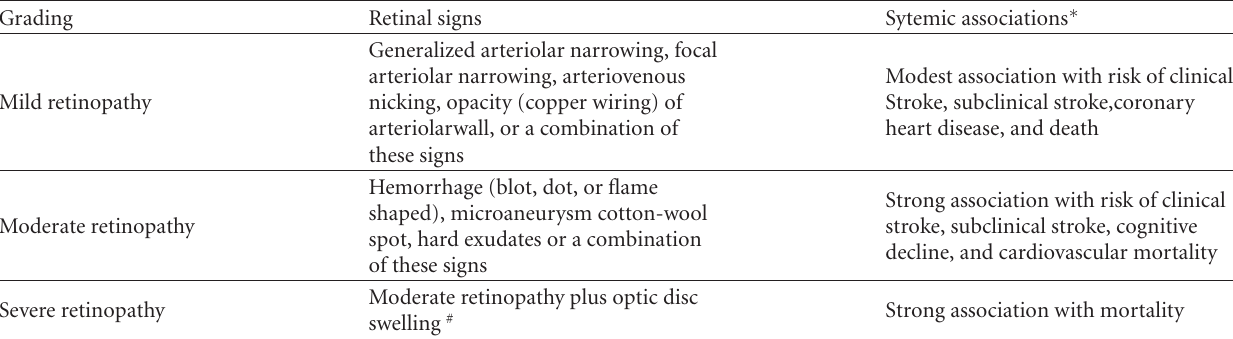
Table 4: Wong and Mitchell’s classification (adapted from [80]).